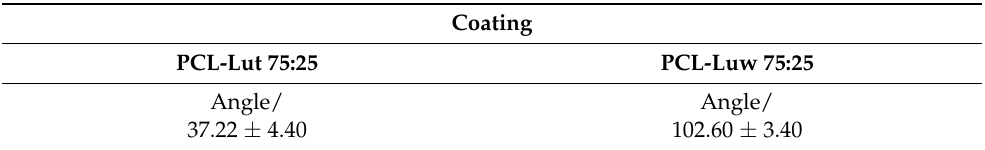
Table 7. Water-coating contact angles (Mean ± SD, n = 3). Simultaneous Thermal Analysis of the Implants.